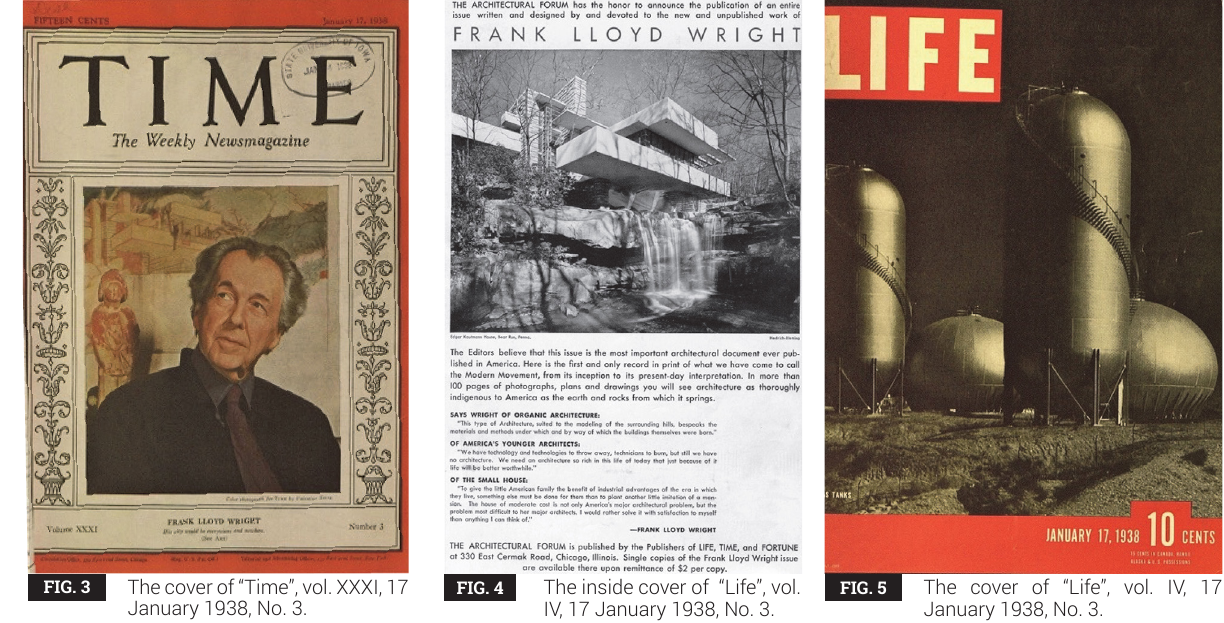
January 1938, No. 3.